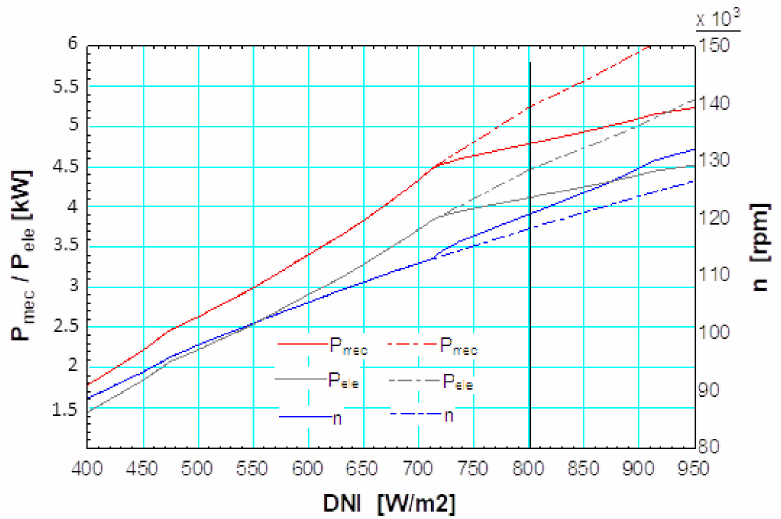
Figure 15. System performance (mechanical power available at the shaft, electrical power output, generator speed) as a function of DNI. The continuous and the dotted lines are referred to the present and the “generator optimised” systems,